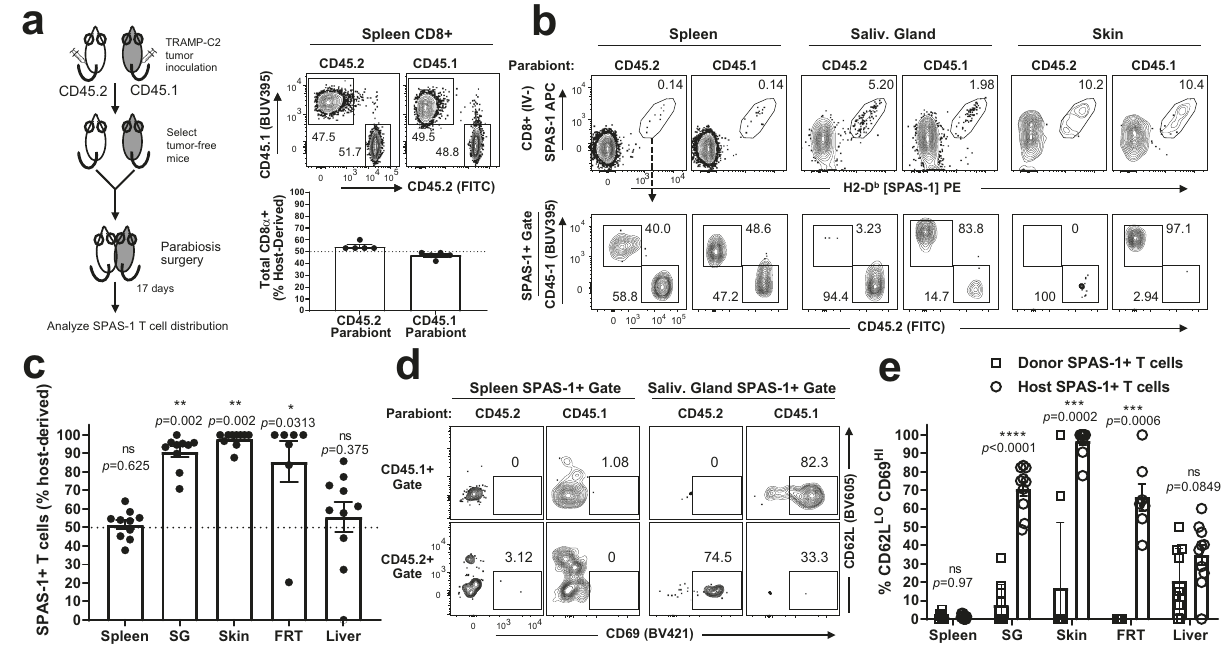
Fig. 3 SPAS-1 + memory T cells in non-lymphoid tissues are tissue resident. Female CD45.2 and CD45.1 mice were challenged s.c. in opposite fl anks with TRAMP-C2 tumor cells. Mice lacking tumors 6 weeks later but exhibiting residual SPAS-1 + CD8 + memory T cell response in the blood were selected. a Schematic of experimental design. Parabiosis was performed to surgically join the circulation of challenged but tumor-free CD45.2 and CD45.1 mice. After 17 days of equilibration, mice in each pair were individually injected i.v. with 3 µ g of FITC-labeled anti-CD8 α antibody 3 min prior to harvest, to mark CD8 + T cells in the circulation. Single-cell suspensions from the indicated organs were prepared and stained for fl ow cytometry. CD8 + T cells from the spleen of one parabiotic pair are discriminated with antibodies to CD45.2 and CD45.1, quanti fi ed in the bottom graph. Data points in ( a ), ( c ), ( e ) re fl ect individual biological replicate mouse pairs ( fi ve pairs total), from one of two similar experiments performed. b Representative fl ow plots visualizing three different tissues of a single parabiotic pair. Top row, SPAS-1 + gate in CD8 + IV- T cells. Bottom row, CD45.2, and CD45.1 staining of SPAS-1 + T cells from the plot above. c Quanti fi cation of data from fi ve parabiotic pairs, calculating the proportion of SPAS-1 + T cells in each tissue that was derived from the host mouse as fraction of the total from both host and donor mouse. Signi fi cance was determined by two-sided Wilcoxon sign-rank test with a theoretical value of 50; * p < 0.05; ** p < 0.01. d Representative fl ow plots showing the expression of CD62L and CD69 cell surface phenotype of IV- SPAS-1 + T